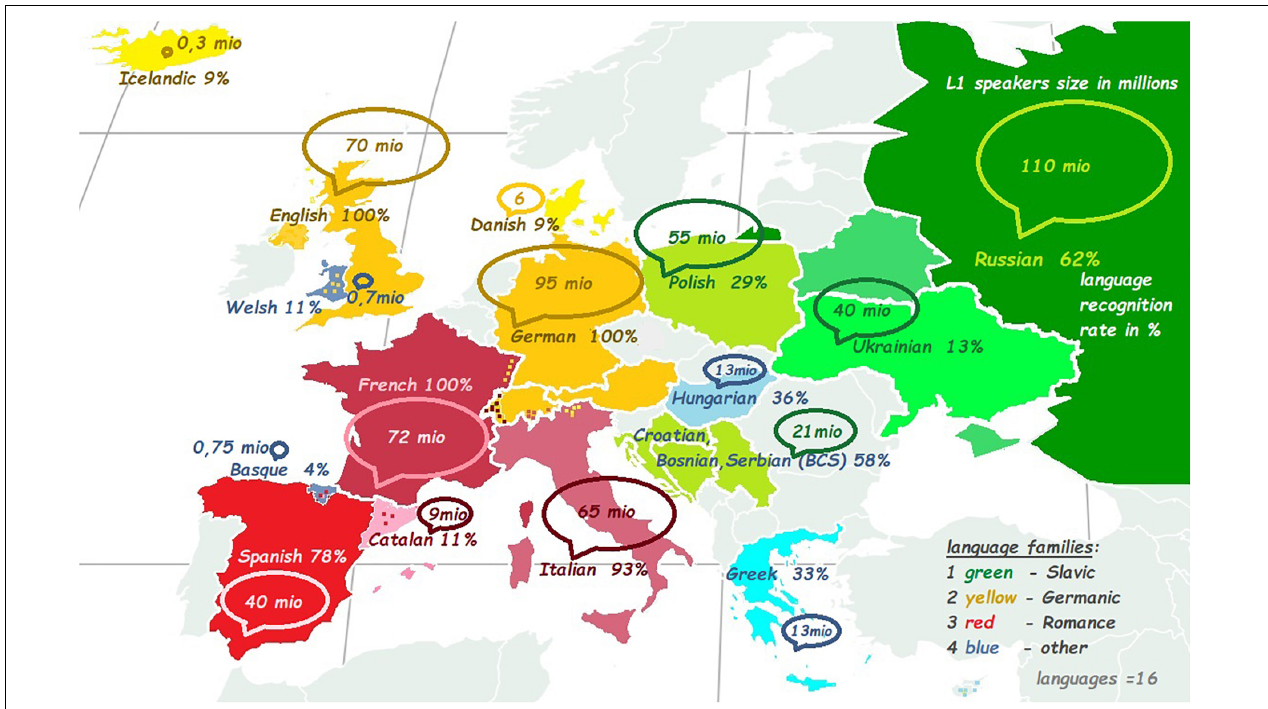
FIGURE 1 | The number of speakers in millions and the recognition rate in percentage. The green color refers to Slavic languages, yellow – Germanic languages, red – Romance languages, and blue indicates other language families or languages-isolates.